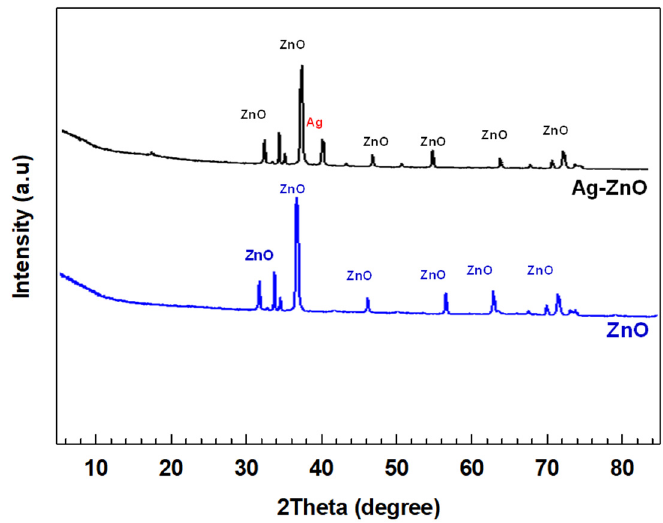
Figure 2. XRD patterns of ZnO and Ag-ZnO photocatalysts.